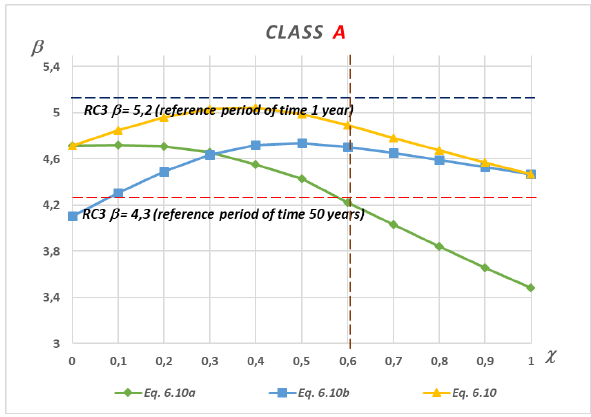
Figure 5: Reliability coeflcient curves β and load factor χ for the class A execution of works and three different combinations of standard coeflcients (formulas: 6.10a, 6.10b, 6.10) - reliability class